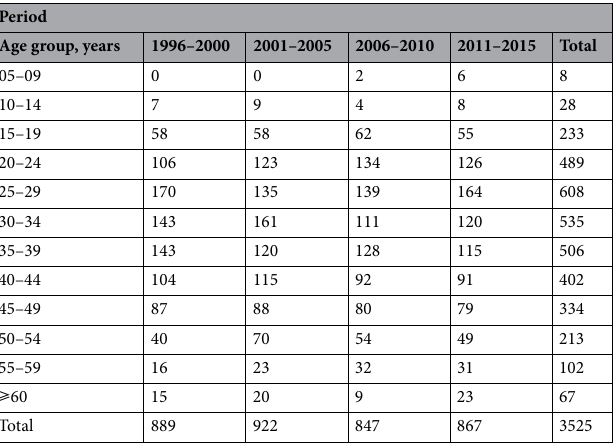
Table 1 . Distribution of new multiple sclerosis (MS) cases in Lorraine by period of MS onset during 1996–2015 (n =